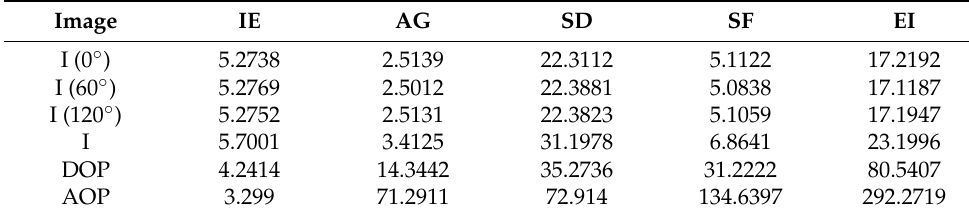
Table 1. Objective evaluation index of polycrystalline silicon solar panel. Image